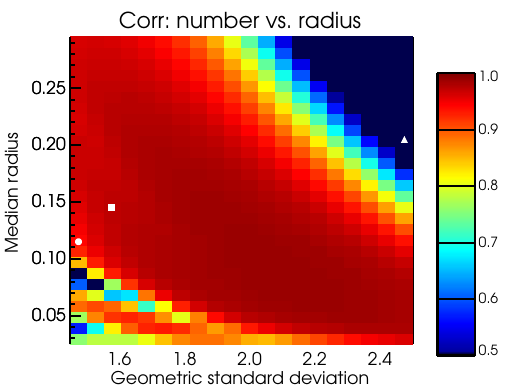
Corr: number vs. radius